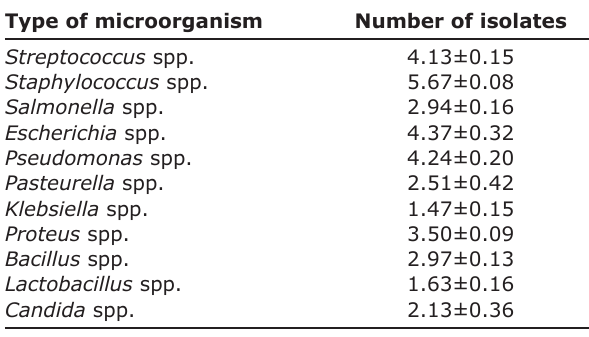
Table-4: Number of microorganisms (lg) in 1 cm 3 of cows’ udder secretions with